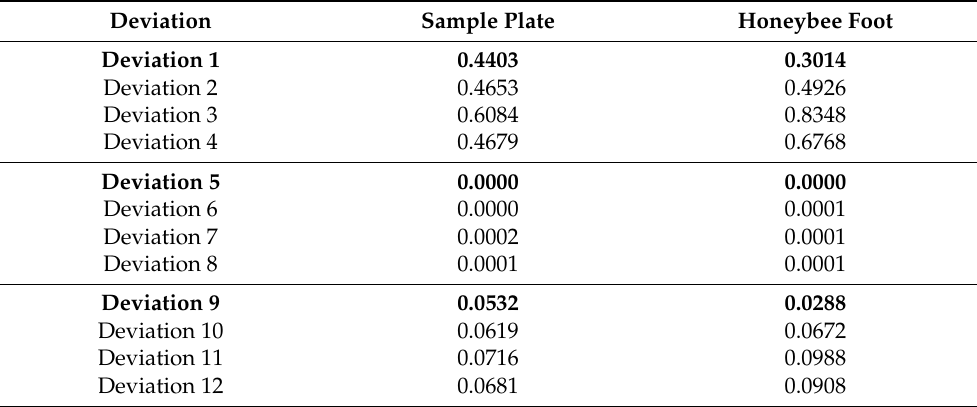
Table 3. Maximum, minimum and average deviation of the green dotted line, the blue point, the orange point line, the purple double-point line from the red solid